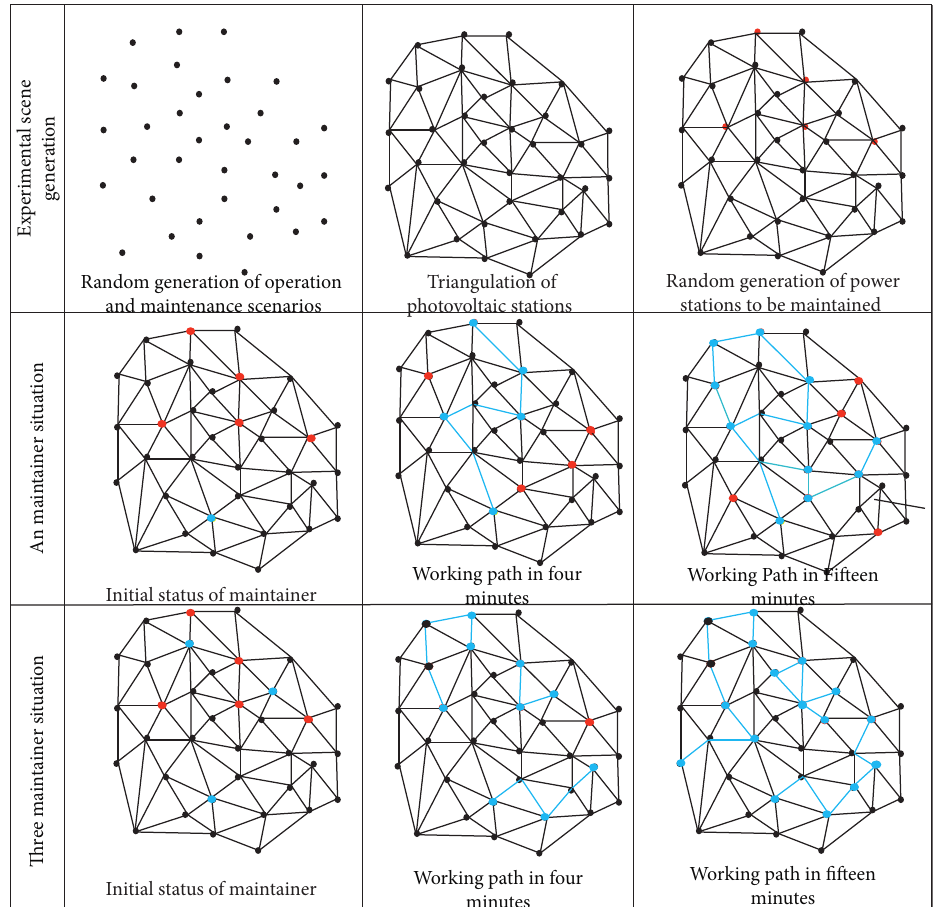
Figure 3: Scenario construction and operation and maintenance path